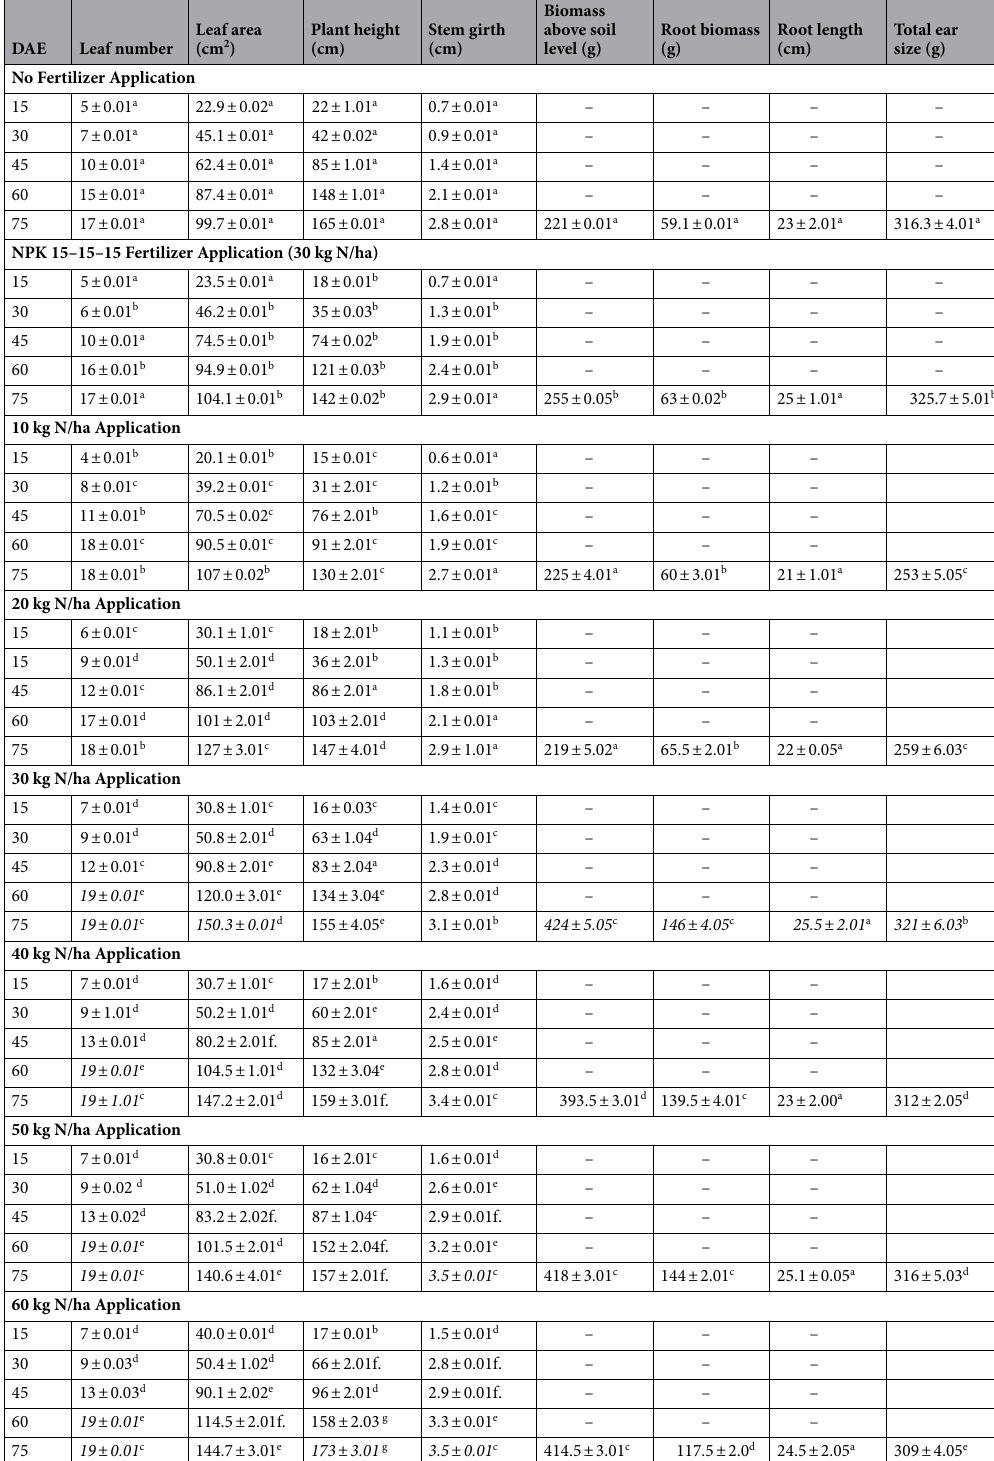
Table 6. Results of Phyto-Assessment in control, NPK 15–15–15 and Carica papaya fruit peel organic fertilized experiments using Maize ( Zea mays ) as test plant. Values shown in table are means of triplicate analyses; DAE = Day after Emergence; italics values are the highest obtained for each phyto-parameter; superscripts with same letters are statistically the same for a particular parameter across the different fertilizer treatments (Organic fertilizer and control experiments) by the Tukey’s test at